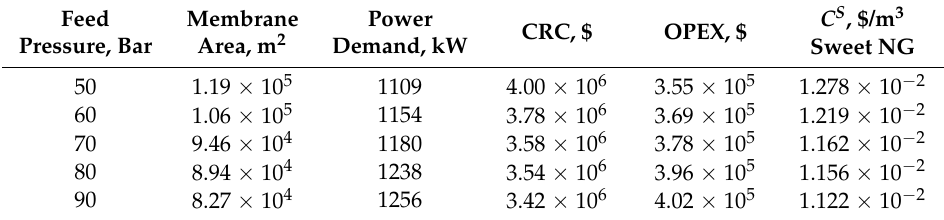
Table 3. The simulation and cost estimation results of Scenario